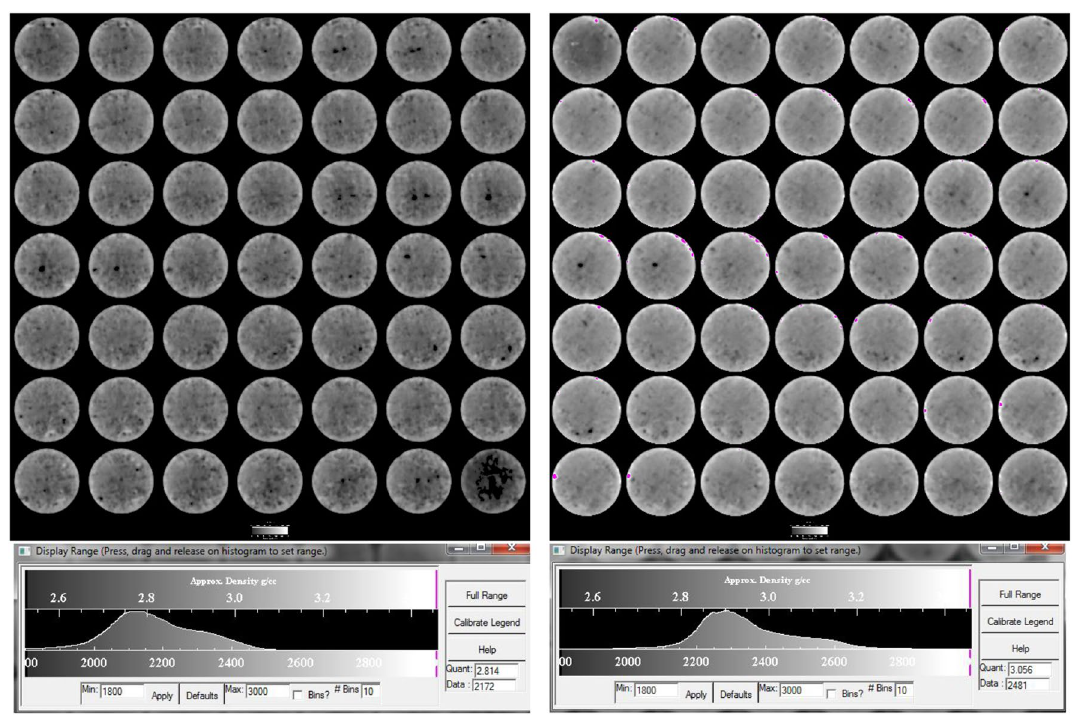
Fig. 15 CT scan of sample 3 showing: (left) pre-filtration-loss slices and (right) post-filtration-loss slices